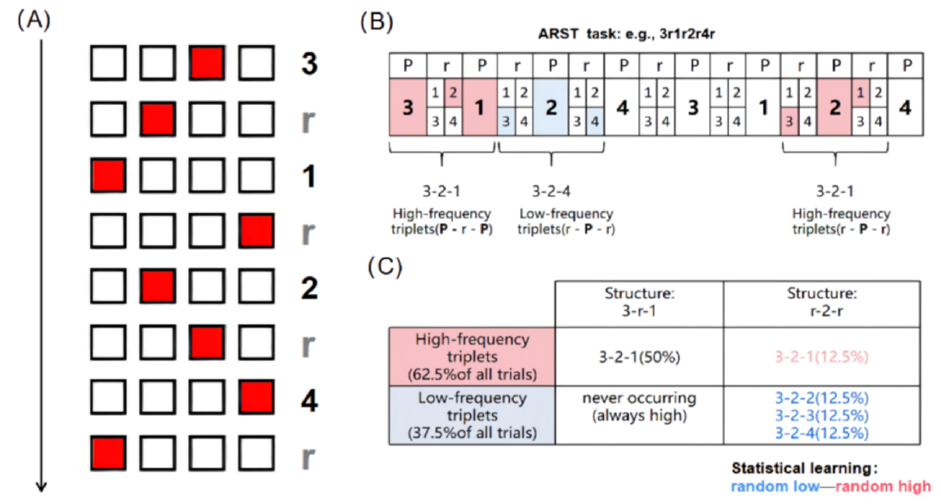
Figure 1. Paradigm of the alternating serial reaction time (ASRT) task (refer to [18,40]). ( A ) ASRT task: four squares were arranged horizontally in the center of the screen, with one of the squares filled with red as the target stimulus. The sequence order of the four possible positions (encoded as 1, 2, 3, and 4, respectively) of the target stimulus was determined by a sequence of eight elements (e.g., 3r1r2r4r, where the number represents the position of the four squares on the screen, and r represents events randomly selected from four possible positions). The stimulus remained visible until the participant pressed the corresponding key, and the inter-stimulus interval was 120 ms. ( B ) In the alternating sequence structure, some runs of three consecutive elements (called triplets) occurred more frequently (pink) than others (blue). In the sequence example shown (3-r-1-r-2-r-4-r), the triplet of r-1-r, r-2-r, r-4-r, or r-3-r is called a random triplet because it includes two random elements (the first and third elements) and only one pattern element (the second element) in the middle. ( C ) In the example shown, the triplet 3-r-1 has a probability of 62.5% and is called a high-frequency triplet (pink). The probability of occurrence of a pattern triplet is 50%; therefore, it is called a pattern high-frequency triplet. In a random triplet (r-2-r), the triplet 3-2-1 has a probability of 12.5%, so it is called a random high-frequency triplet (pink). In contrast, triplets such as 3-2-2, 3-2-3, and 3-2-4 have a low probability (12.5%) of occurring and are called random low-frequency triplets (blue), because they can only occur when the third element of the triplet is random. Statistical learning is defined as a faster response to random high-frequency triplets than to random low-frequency